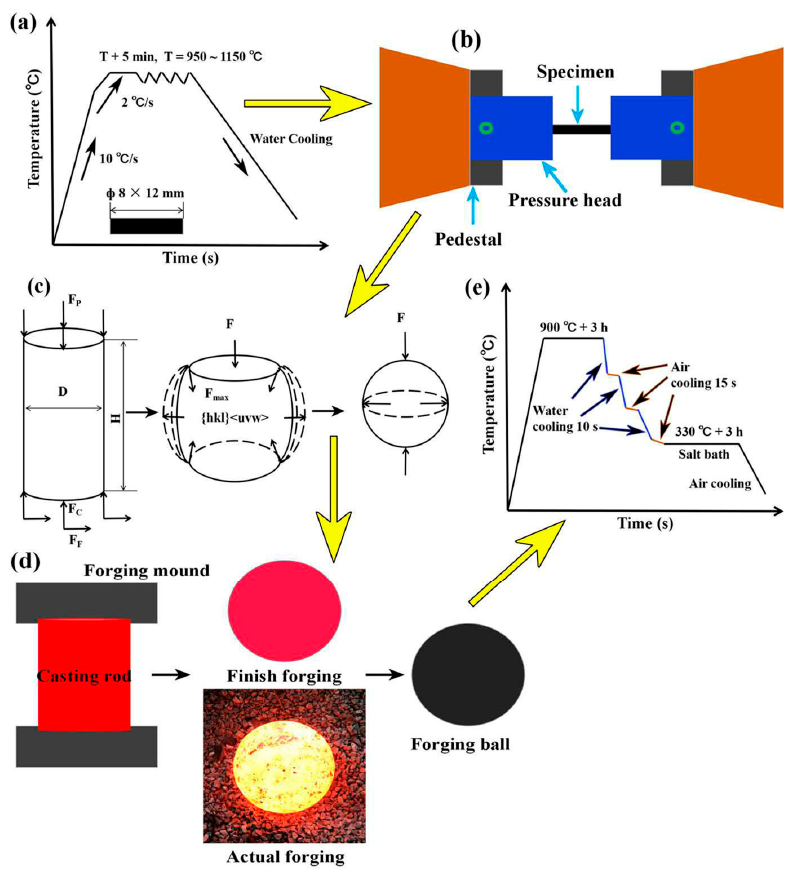
Figure 1. Schematic diagram of the experimental process. ( a ) High temperature compression deformation process at T = 950 °C, 1050 °C, and 1150 °C; ( b ) specimens under unidirectional compression in Gleeble; ( c ) stress and deformation of a cylinder during high temperature forging; ( d ) forging and pressing process of casting rod with height-diameter ratios (H/D) values of 1.5, 1.7, and 2.0; ( e ) heat treatment process of casting and forging.